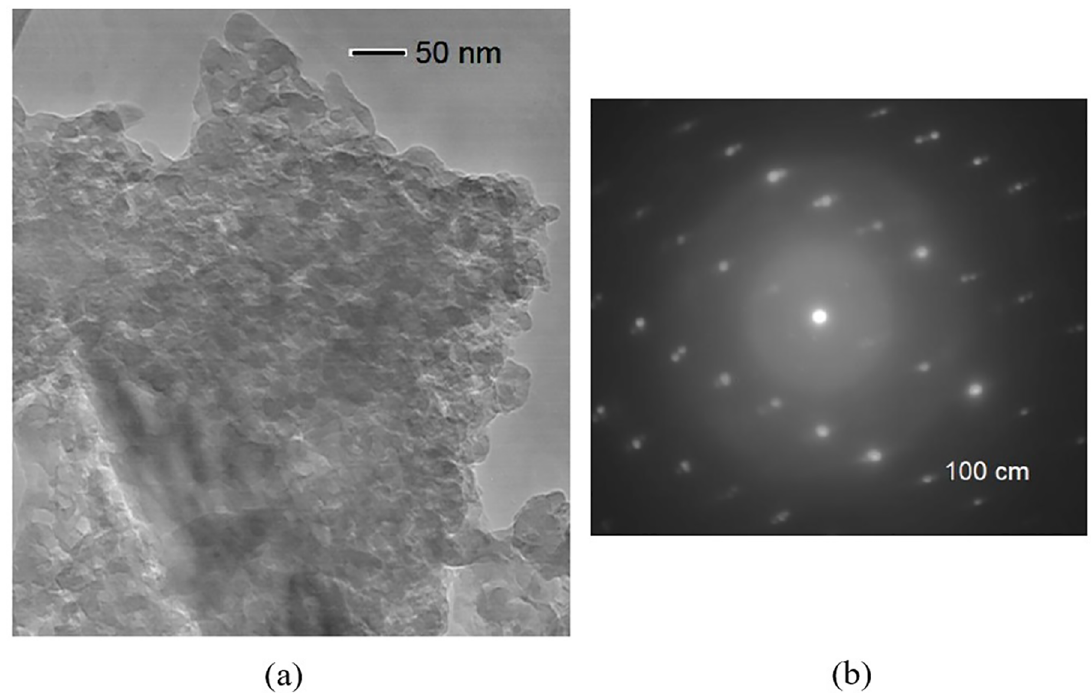
Figure 8. (a) Transmission electron micrograph of WPG-6-50, showing nanoparticles and revealing in (b) that they are crystalline and are embedded in an amorphous (geopolymeric)